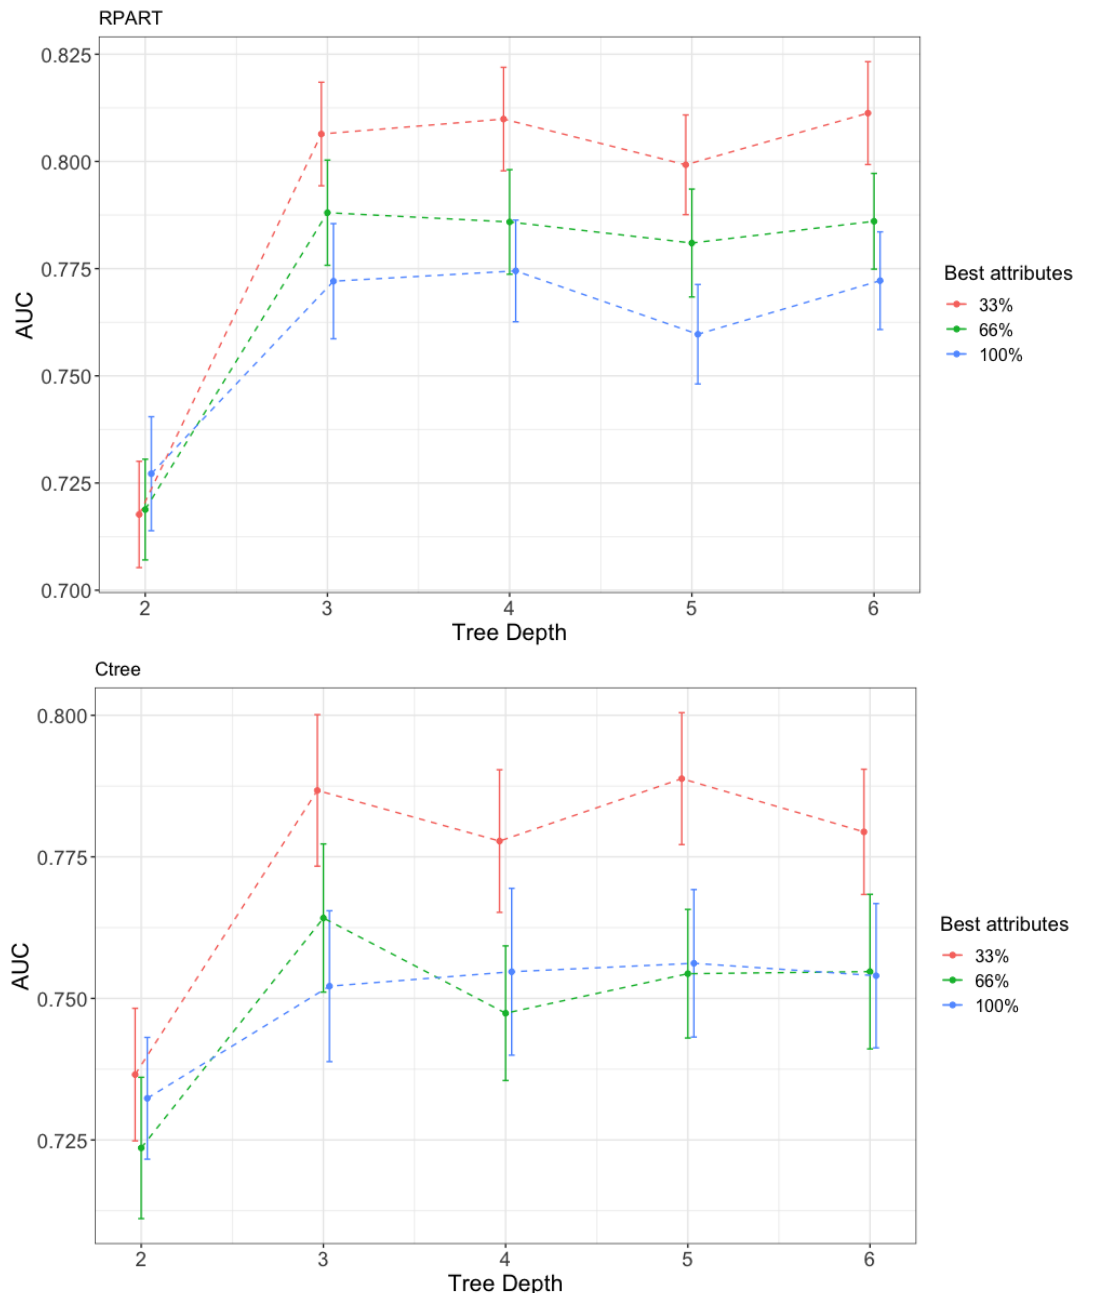
Figure 6. Variation in the performance (AUC) with the tree depth and the percentage of features used. Up, recursive partitioning and regression trees (RPART); Down, conditional inference trees